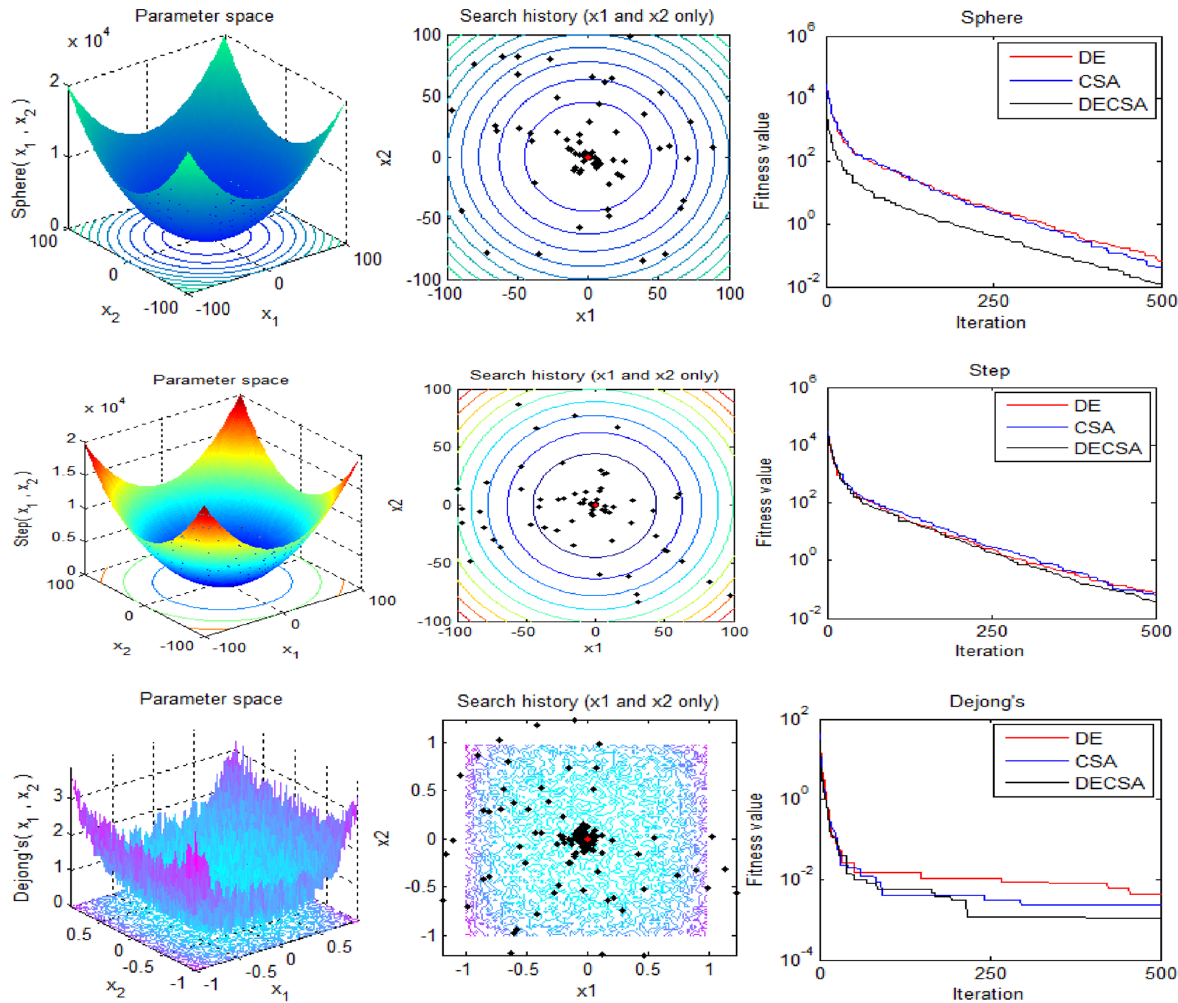
Fig. 3 Convergence characteristics of Uni-modal